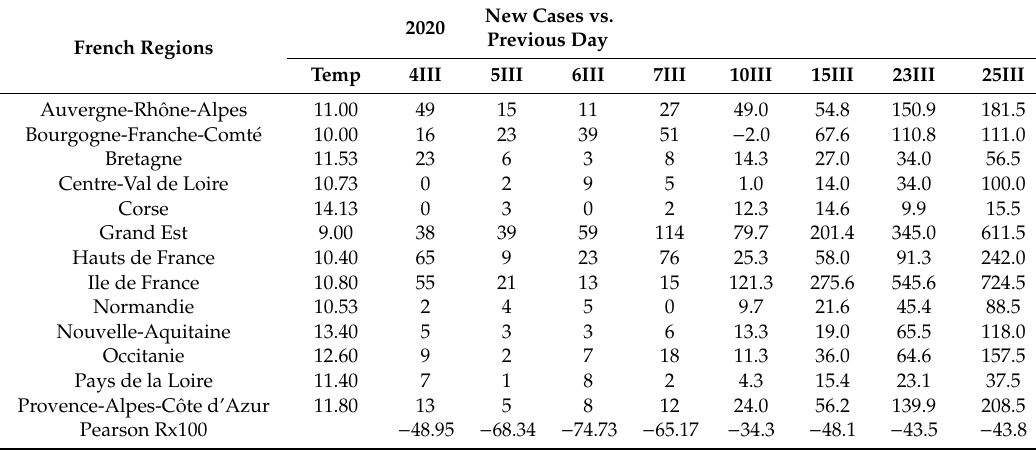
Table 2. Dependence of the covid-19 new cases on temperature across administrative regions of Figure